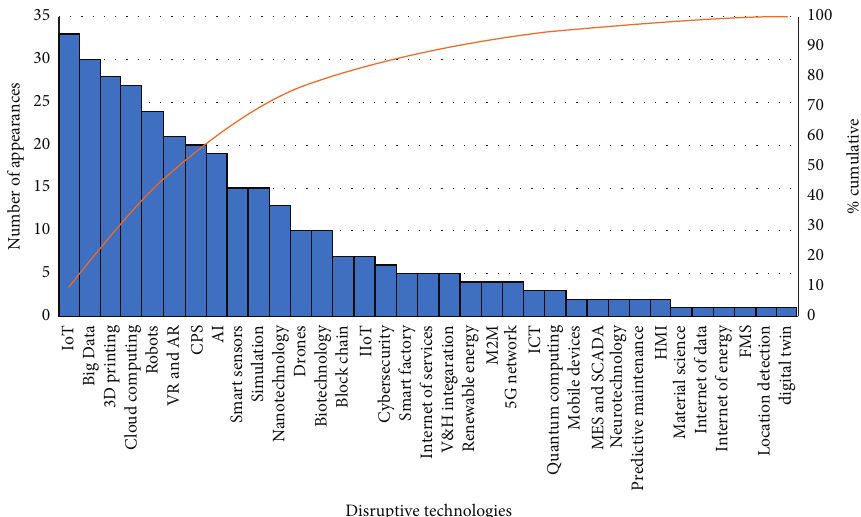
Figure 1: Identification of key disruptive technologies of industry